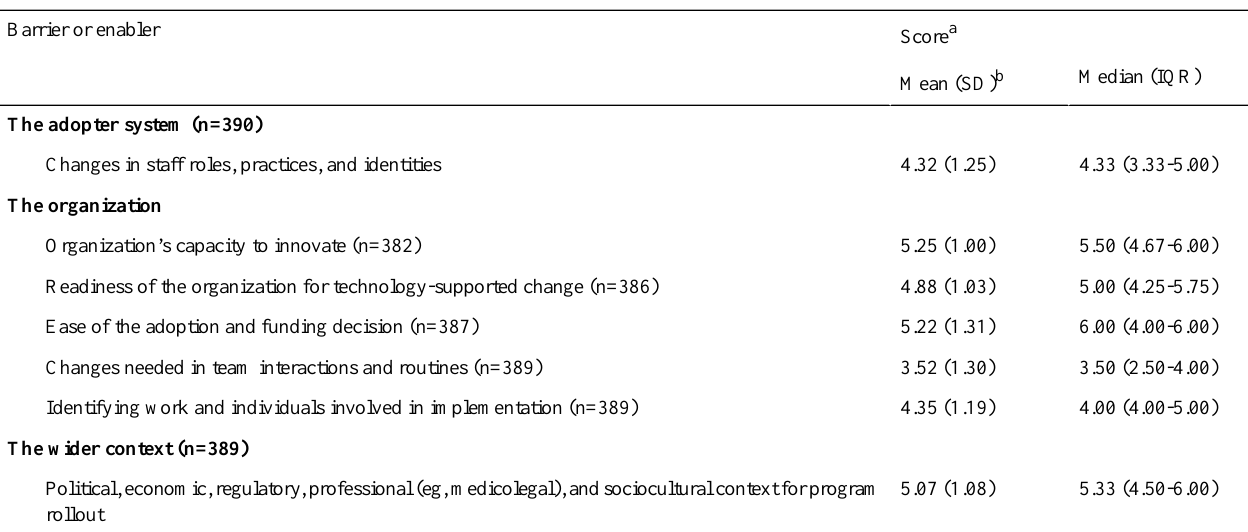
Table 3. Mean and median scores for the nonadoption, abandonment, scale-up, spread, and sustainability subdomain barriers and enablers, as reported by responders.